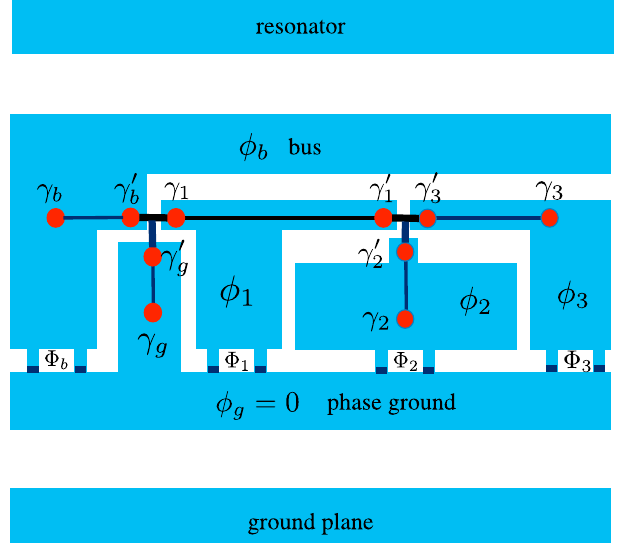
FIG. 11. The π junction proposed by Ref. [43]. The MZM system sits inside a superconducting qubit formed by the bus and ground islands. The topological qubit is embedded into a trans- mission-line resonator to allow read-out of the qubit